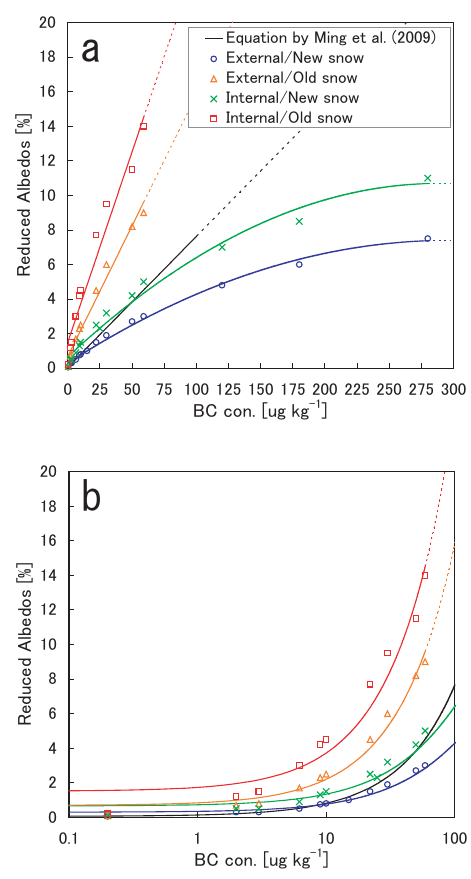
Fig. 7. Albedo reductions for 2 types of BC mixture conditions (ex- ternal and internal mixture, called Ext and Int, respectively) with 2 types of snow conditions (new and old snow, called New and Old, respectively) together with the estimated albedo reductions by the equation of Ming et al. (2009). The employed data were based on the previous studies (Warren and Wiscombe, 1980, 1985; Gren- fell et al., 1994; Hansen and Nazarenko, 2004; Jacobson, 2004). (b) denotes an enlarged (a) for the BC concentration range up to 100µgkg − 1 with log scale for x-axis. The parts of dashed lines denote out of ranges of the employed data. If you use the data esti- mated from each equation in Table 3, and refer to the dashed line for various studies, use caution in your discussion of albedo reductions because there are no supporting observations in these